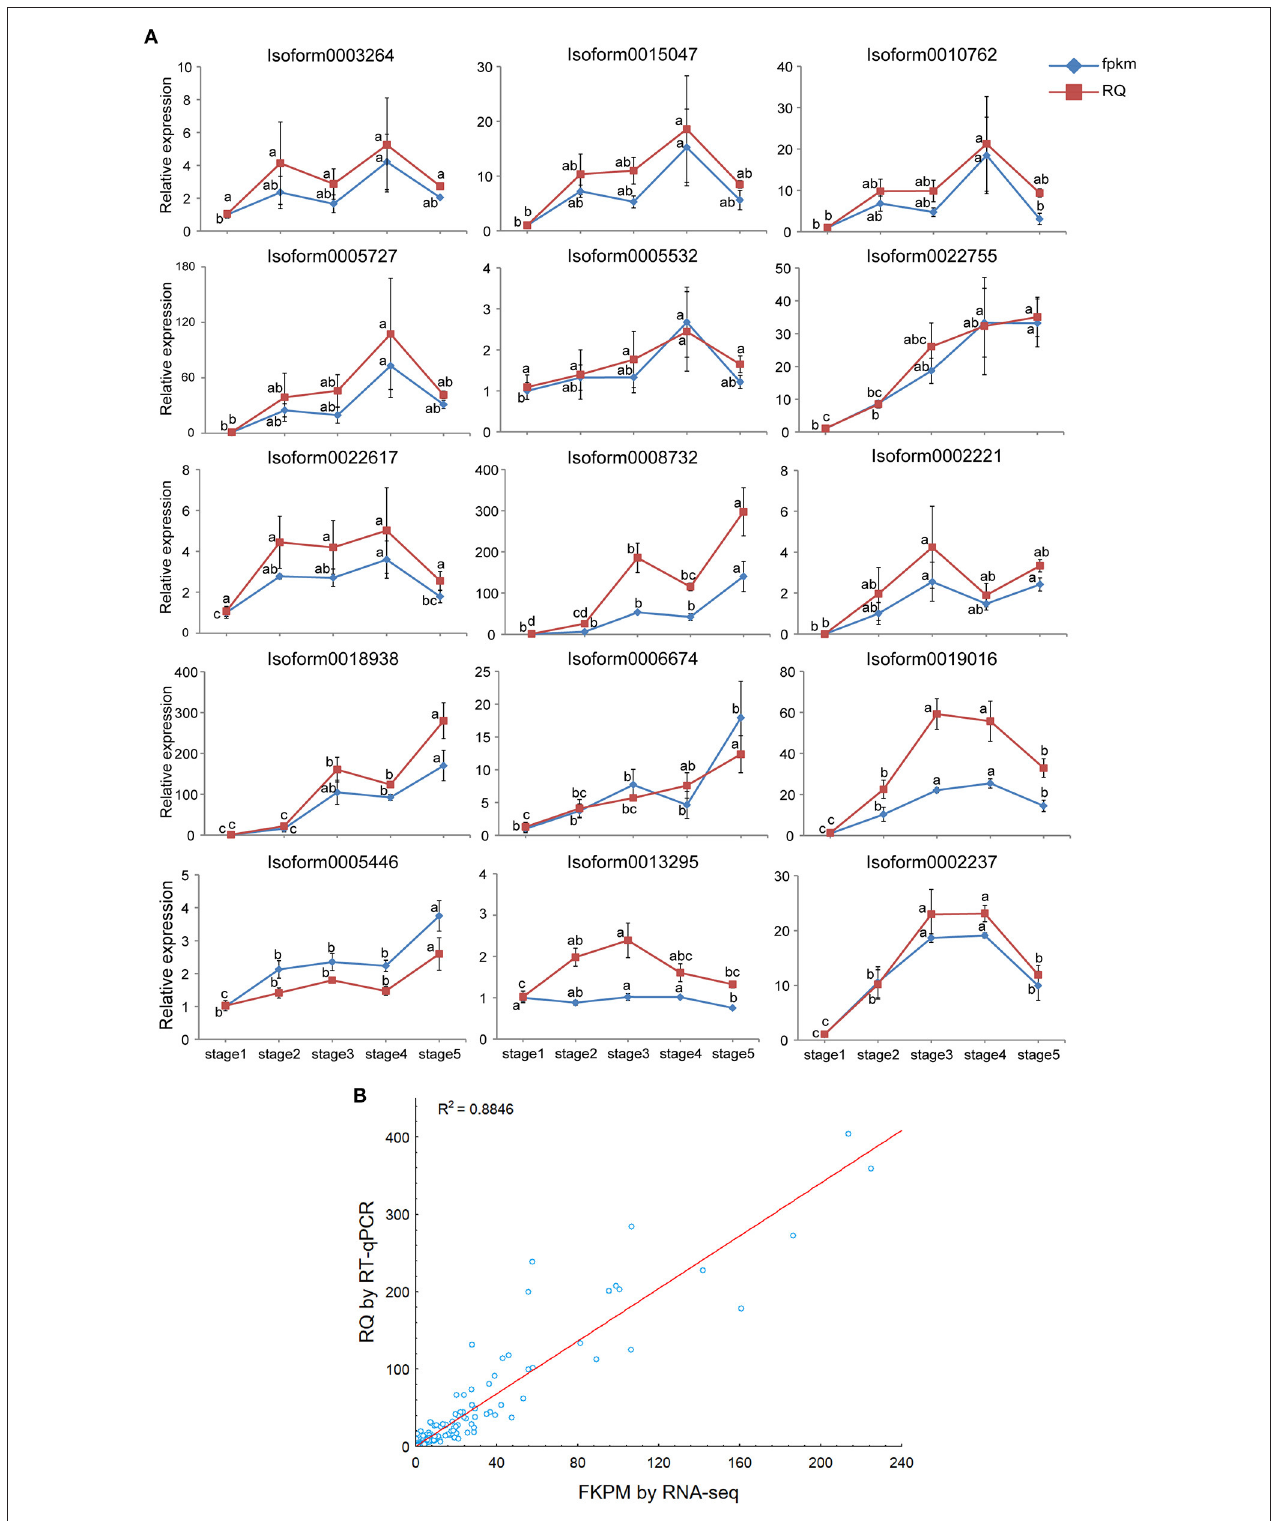
FIGURE 11 | Real-time quantitative polymerase chain reaction (RT-qPCR) validation of 15 structural genes. (A) Expression patterns of the 15 genes involved in the flavonol biosynthesis and polar auxin transport in five post-germination stages of M. pasquieri (from stages 1 to 5). Each column represents an average of three biological replicates, with standard errors indicated by vertical bars. Values with a different accompanying letter are statistically significantly different according to Duncan’s multiple range test at p < 0.05. (B) Correlation of the expression levels of 15 selected genes measured by RNA-seq and RT-qPCR.